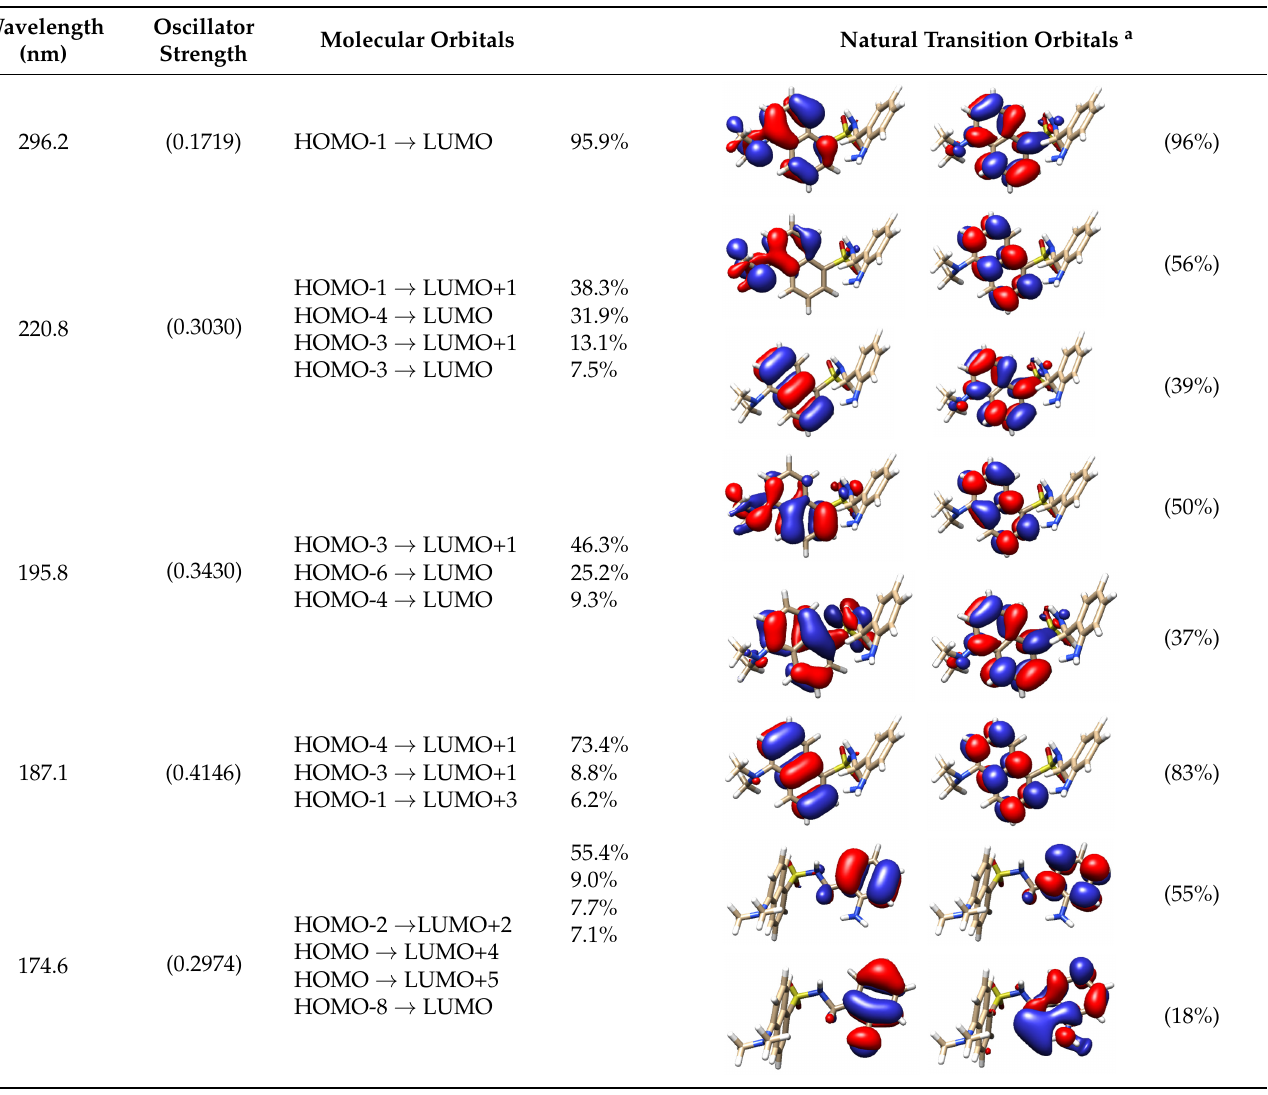
Figure 3. Experimental ( left ) and theoretical ( right ) profiles for the electronic spectrum of DsA. The signal assignment of the two moieties of the molecule has been included as a schematic. The orange arrows show the bands associated with the dansyl moiety, and the green arrow shows the band associated with the aniline moiety. Vertical lines indicate individual electronic transitions listed in